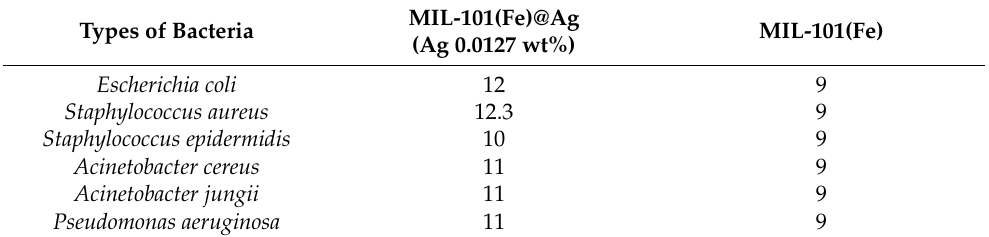
Table 1. Inhibition-zone diameters of MIL-101(Fe) and MIL-101(Fe)@Ag (Ag 0.0127 wt%) (mm). Types of